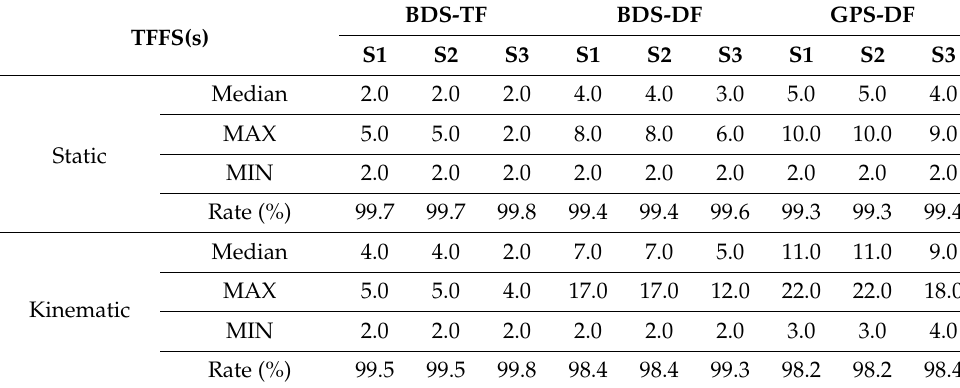
Table 2. Statistics of ambiguity fixing performance of Baseline A, Sampling rate 1